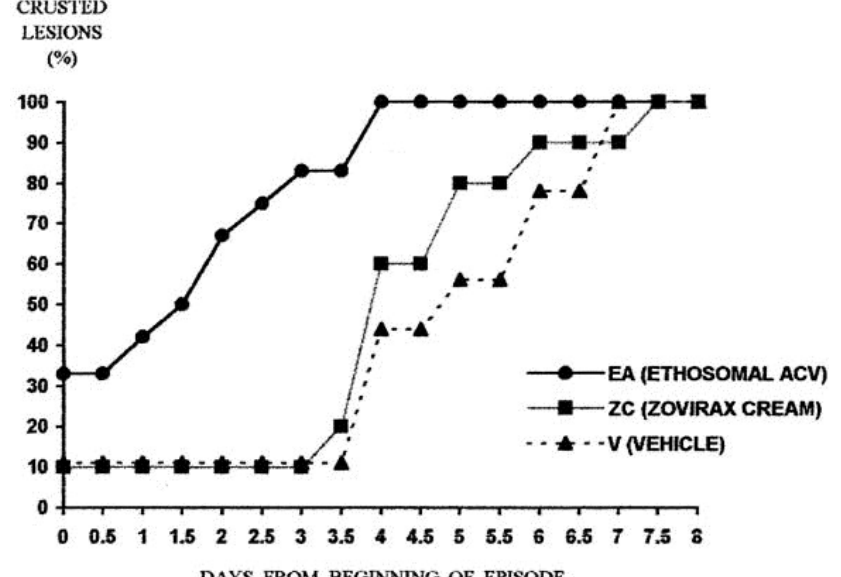
Figure 4. Days to crust formation: parallel arm. Day 0: 33% of lesions aborted in EA subgroup, 10% in ZC subgroup, 11% in V subgroup. Day 3: 80% of lesions crusted in EA subgroup, 10% in ZC subgroup, 11% in V subgroup. Day 4: 100% of lesions crusted in EA subgroup, 60% in ZC subgroup, 44% in V subgroup. Time to crusting of all lesions: 4 days in EA subgroup, 7 days in ZC subgroup, 7.5 days in V subgroup (Reproduced from reference [35] with permission).